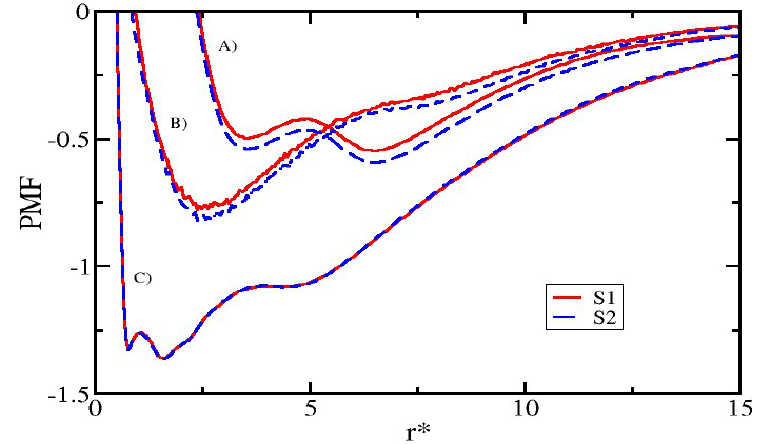
Figure 7. PMF for the two sequences of CS used in this work, S1 (red line) and S2 (blue dotted line), to concentrations of CS reaching 6 mM. PMF for ( A ) lecithin-CS; ( B ) CS-capsaicin; and ( C ) lecithin-capsaicin. All quantities are expressed in reduced DPD units.